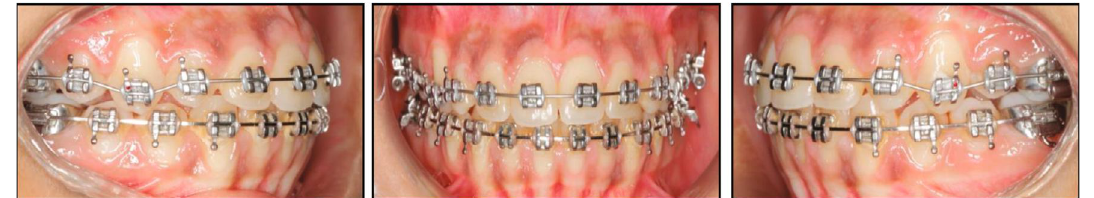
Figure 10: Both upper right and left canines included.